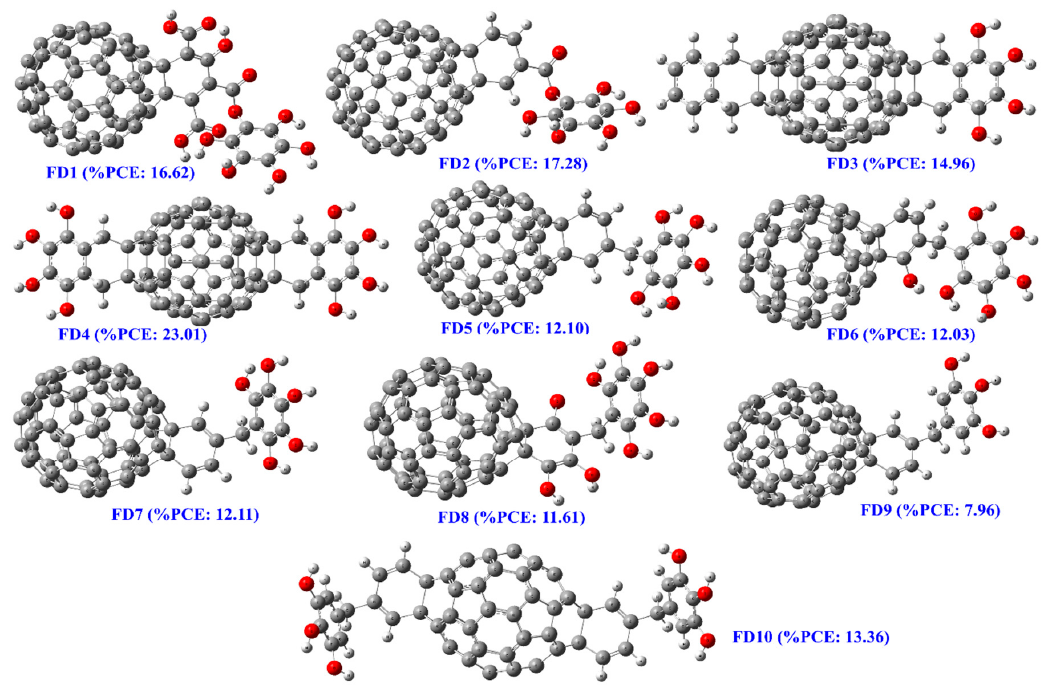
Figure 4. Structure of designed fullerene-derivatives (FDs) as lead acceptor molecule for polymer solar cells (PSCs).